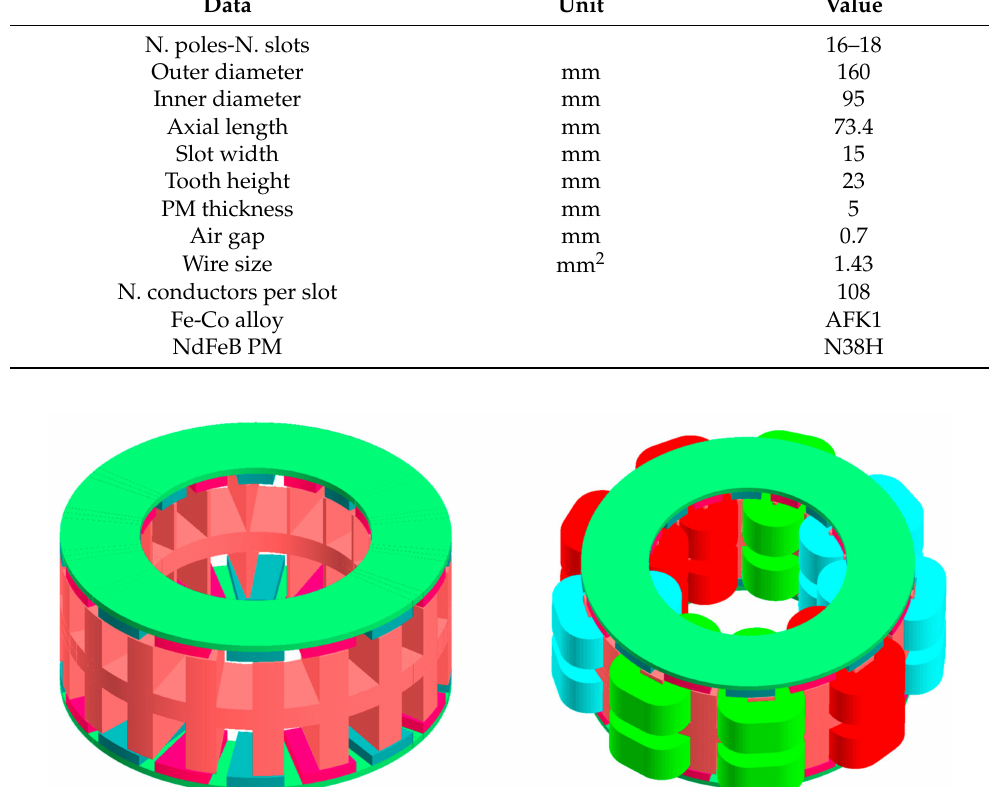
Figure 4. The 3D views of the AFPM motor.